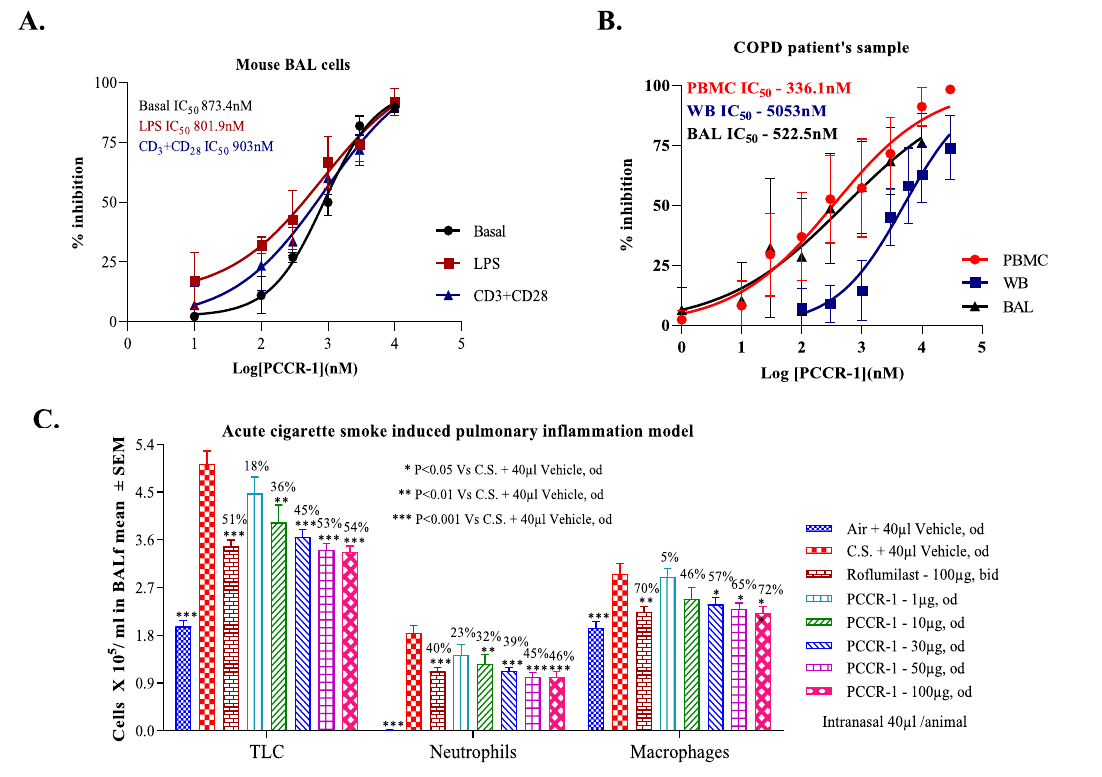
Figure 4. PCCR-1 inhibits ex vivo release of IL-17 in cultured BAL cells from Cigarette Smoke exposed animals and also modulate in COPD patients in PBMC and BALf cells. Ex vivo and in vivo studies of PCCR-1. ( A ) Dose dependent inhibition of IL-17 cytokine from cultured BAL cells from cigarette smoke exposed mice in basal and induced conditions ( B ) Dose dependent inhibition of IL-17 cytokine from human whole blood (n = 5), BAL cells (n = 10) and PBMC (n = 16) derived from COPD patients. The basal value was negligible and on stimulation the IL-17 level was in the range of 49.15, 40.9 and 2098 pg/ml for Whole blood, BAL and PBMC across donors ( C ) Effect on Acute Cigarette Smoke Induced Pulmonary Inflammation mice model at different doses of PCCR-1 (n = 7 per group). ‘n’ is a representative data from one to four donors in